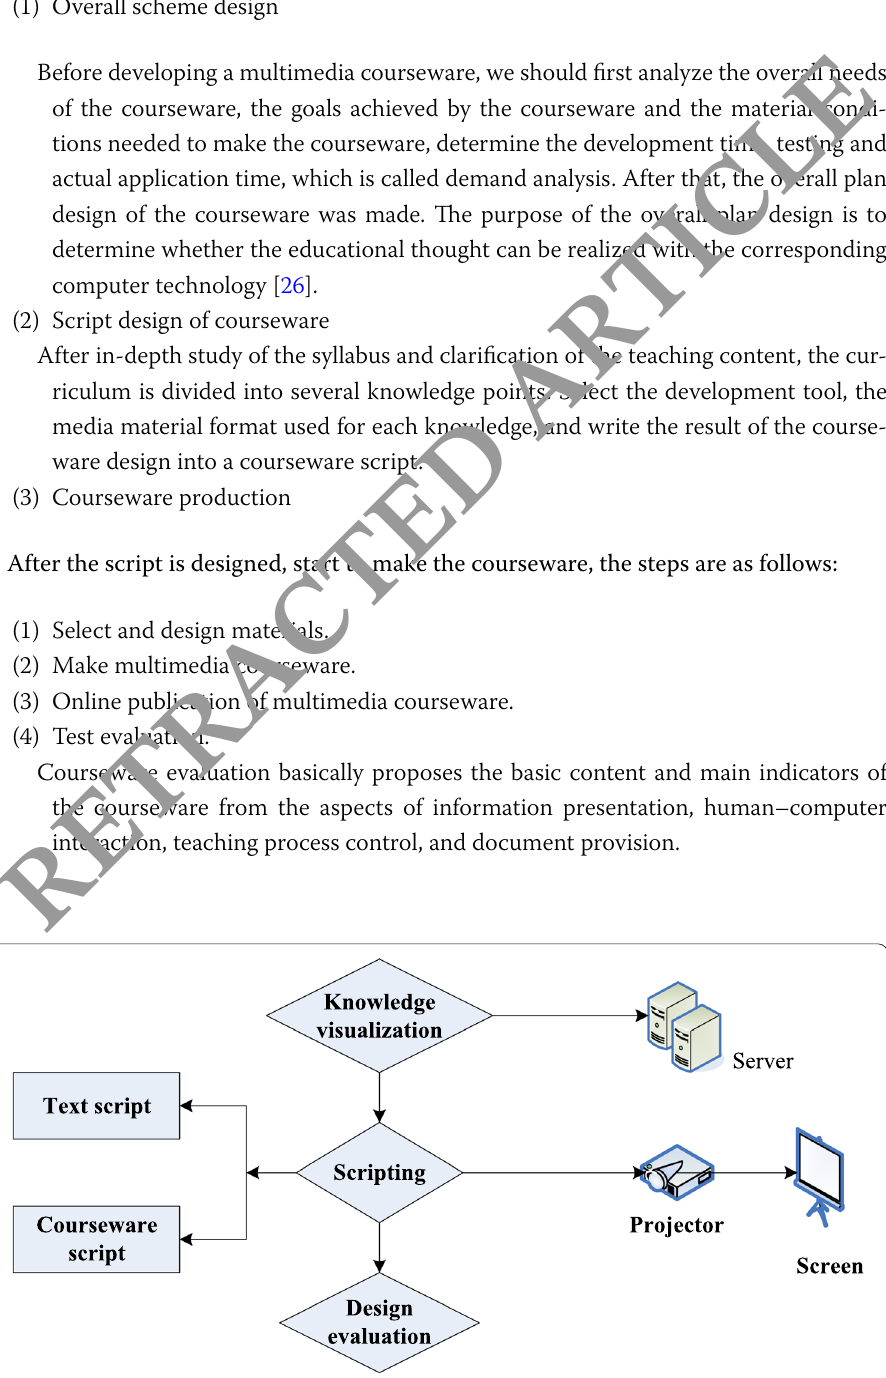
Fig. 1 Courseware design